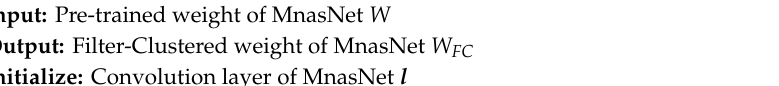
Algorithm 2. Compression of MnasNet